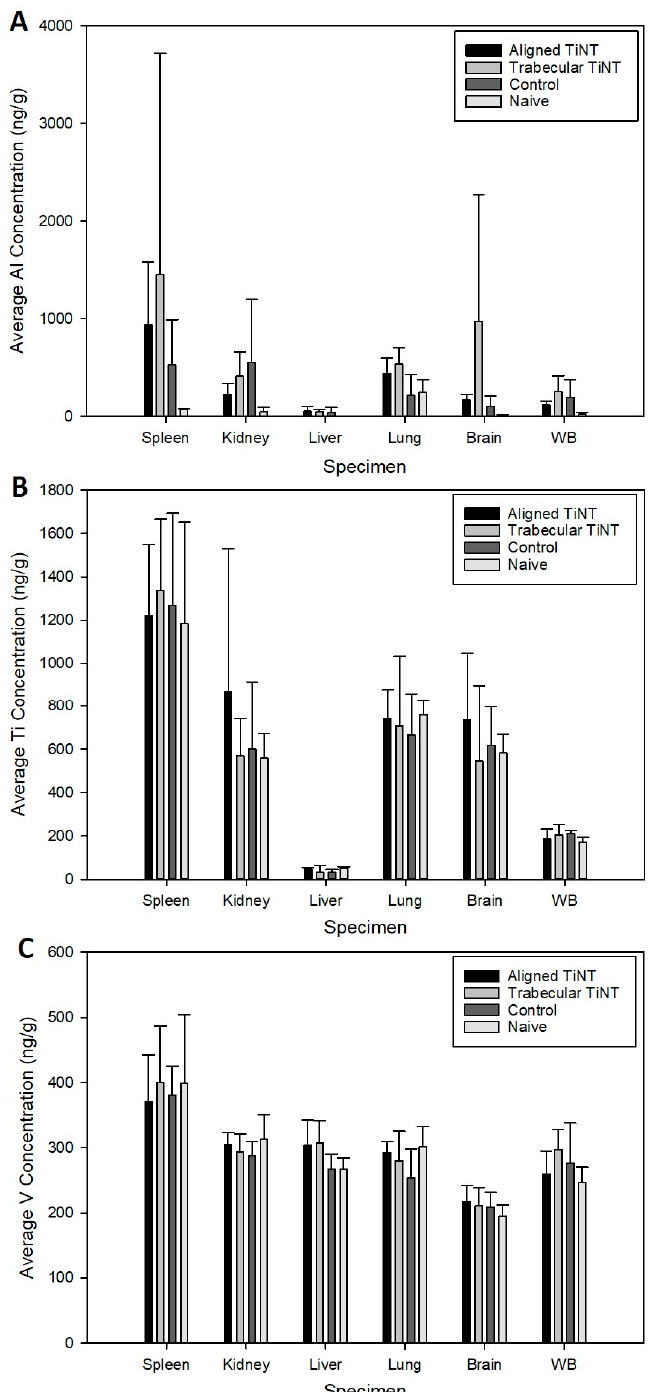
Figure 6. Concentration of aluminum ( A ), titanium ( B ), and vanadium ( C ) in remote organs and whole blood for each group. (WB = whole blood). For aluminum concentration, significant comparison: trabecular TiNT vs. control, p = 0.022.